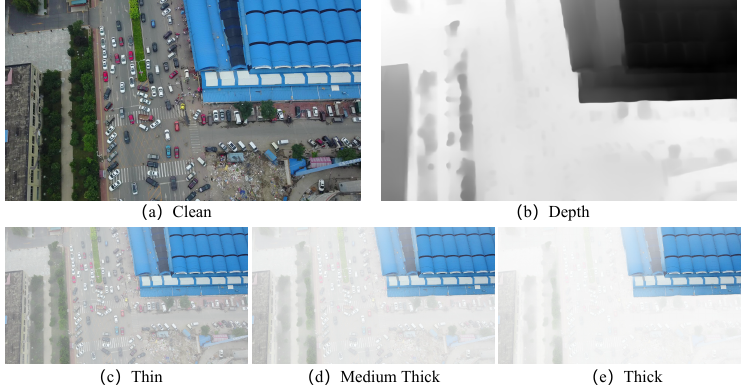
Figure 7. Examples of images from our Visdrone_Foggy dataset. ( a ) The original image; ( b ) The estimated depth map; ( c ) The image with thin fog; ( d ) The image with medium thick fog; ( e ) The image with thick